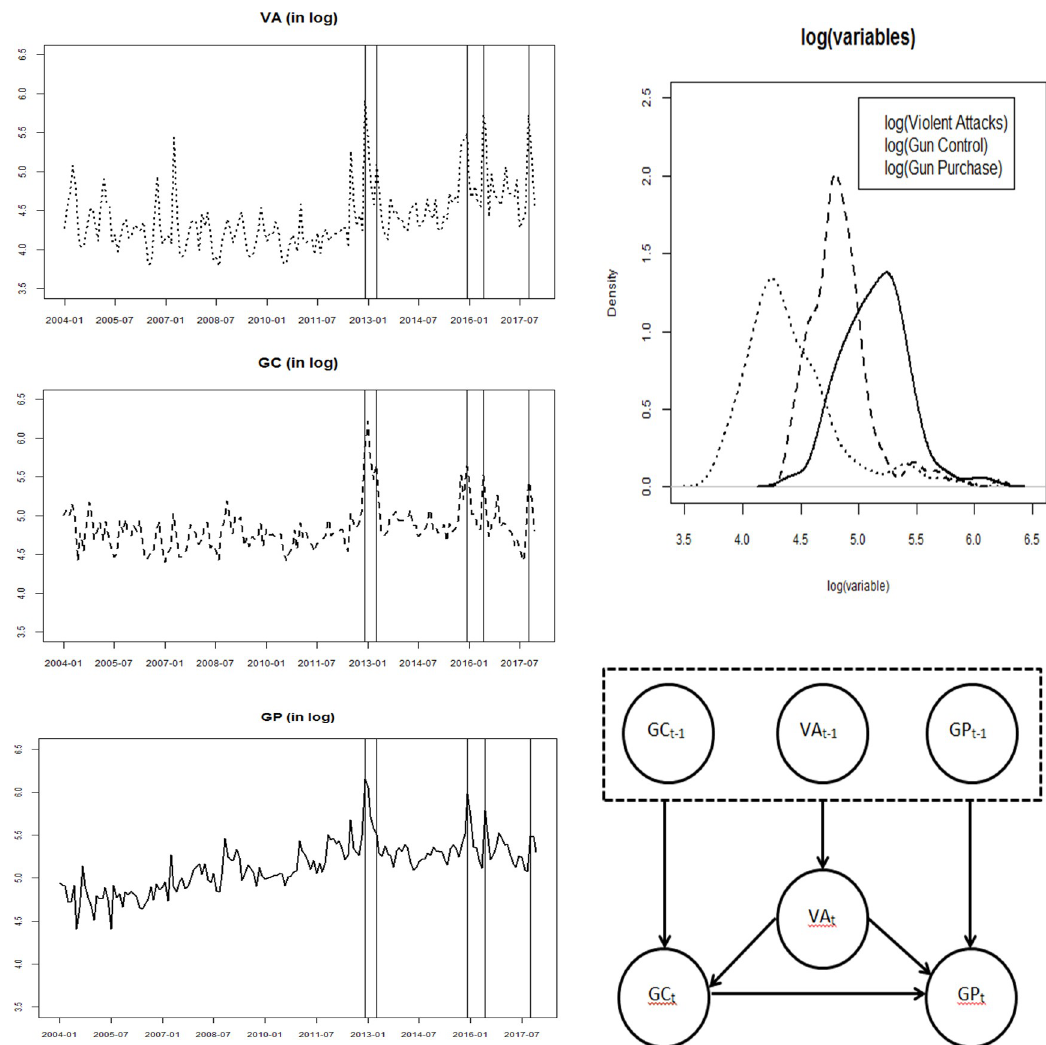
for the variable and t represents the current observation period. Arrows represent the directionality of the causal relationships. Vertical lines mark the dates of several violent attacks (from left to right: Sandy Hook Elementary School, Boston Marathon, San Bernardino regional center, Orlando night club, and Las Vegas concert), which coincide with the peaks of these